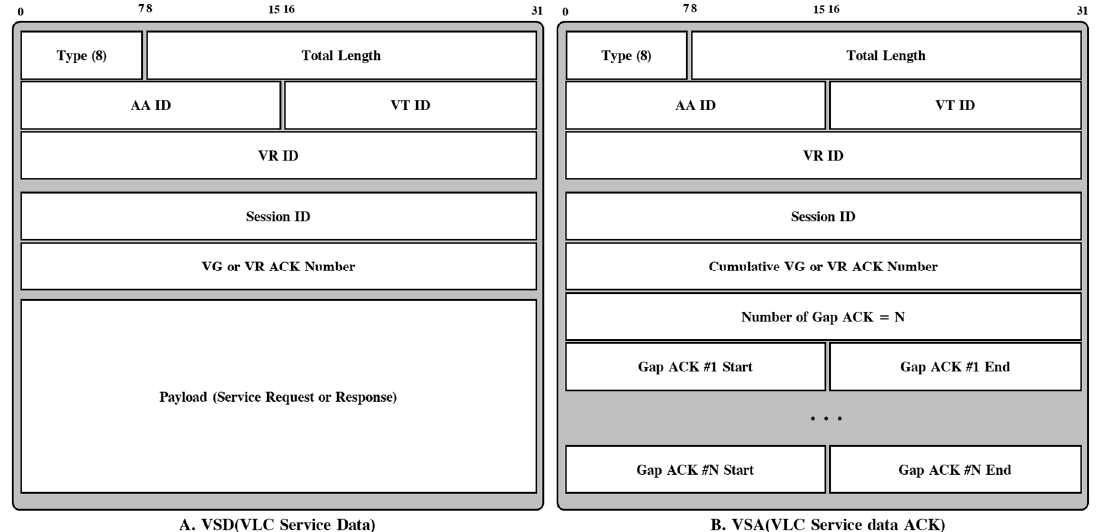
Figure 12. VLC Service Data (VSD) and VLC Service data ACK (VSA) messages.